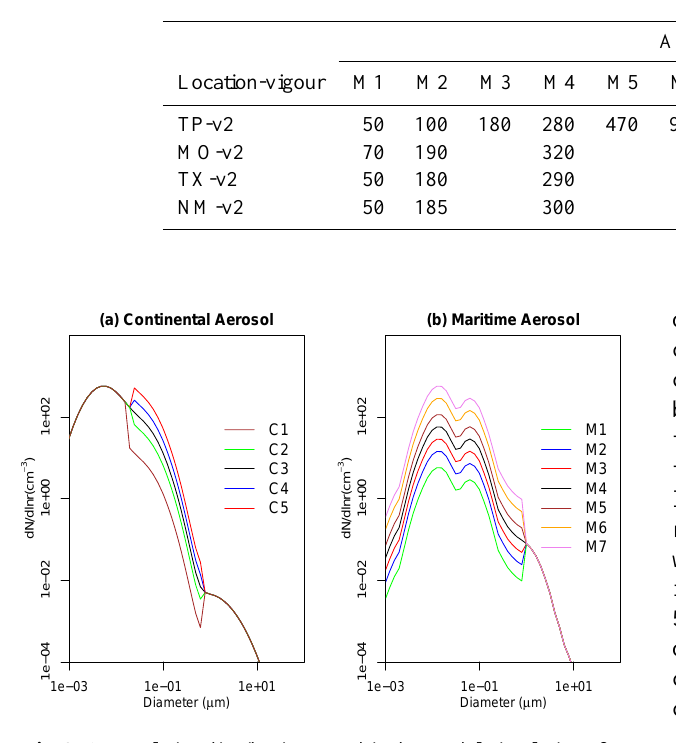
Table 2. Maximum cloud base drop number attained for different thermodynamic environment and aerosol loadings for the medium CAPE runs (v2). C=aerosol distributions based on continental profile (Fig. 2a), M=aerosol distributions based on maritime distributions (Fig. 2b).